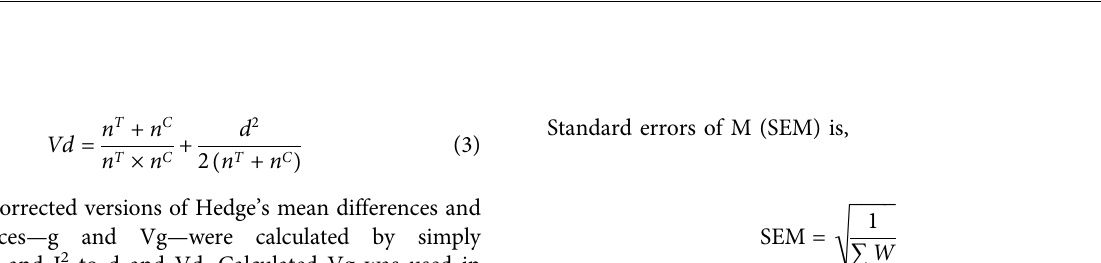
FIGURE1 | PRISMA (Preferred ReportingItemsfor Systematic Reviews and Meta-Analyses) fl owchart showing the selection of studies eligible for a meta-analysis of the effect size of inoculation with endophytic bacteria on the host plant biomass in response to heavy metal stress (aluminum, arsenic, cadmium, copper, chromium, manganese, nickel, lead, and